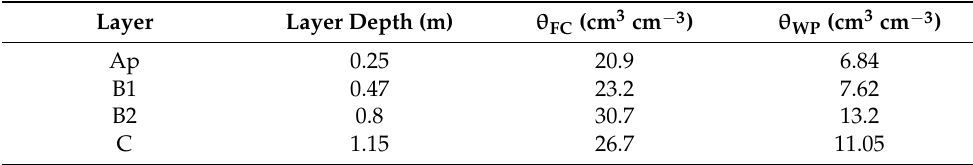
Table 1. Main characteristics of Luvisols [35].